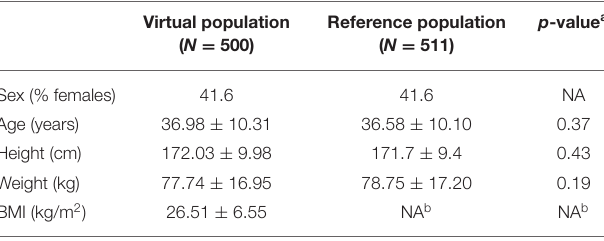
TABLE 4 | Demographic characteristics of the adult virtual population and the reference population.